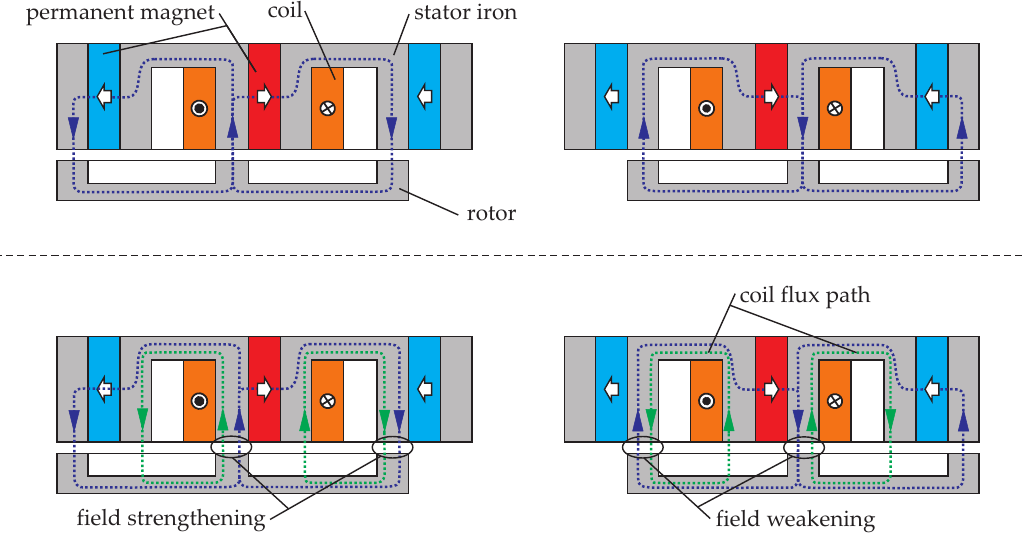
Figure 2. Principles of torque and force generation: Torque is created by an energized stator coil with angle-dependent permanent magnetic flux linkage (illustrated at the top for two different rotor angles), while force is created by field strengthening and weakening (illustrated at the